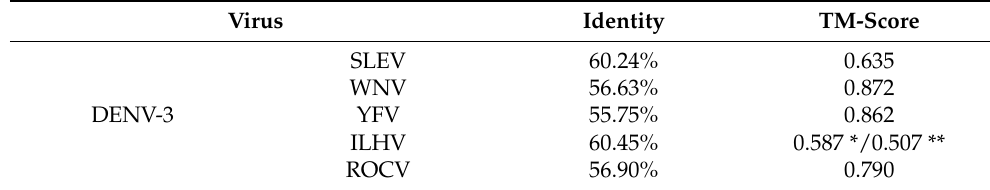
Table 6. Sequence and structure comparison of DENV and the other flavivíruses. Virus Identity TM-Score SLEV 60.24% DENV-3